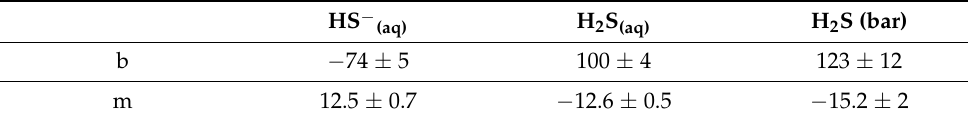
Table 3. Coefficients of a linear regression to the calculated [HS − ] and [H 2 S] aqueous concentrations and the H 2 S gas partial pressure in the pH range of 6.6 to 7.5 units. The uncertainties in the values of b and m are indicated in the table. The units of b and m are moles/L in the case of the concentration of aqueous species and bar in the case of H 2 S gas.